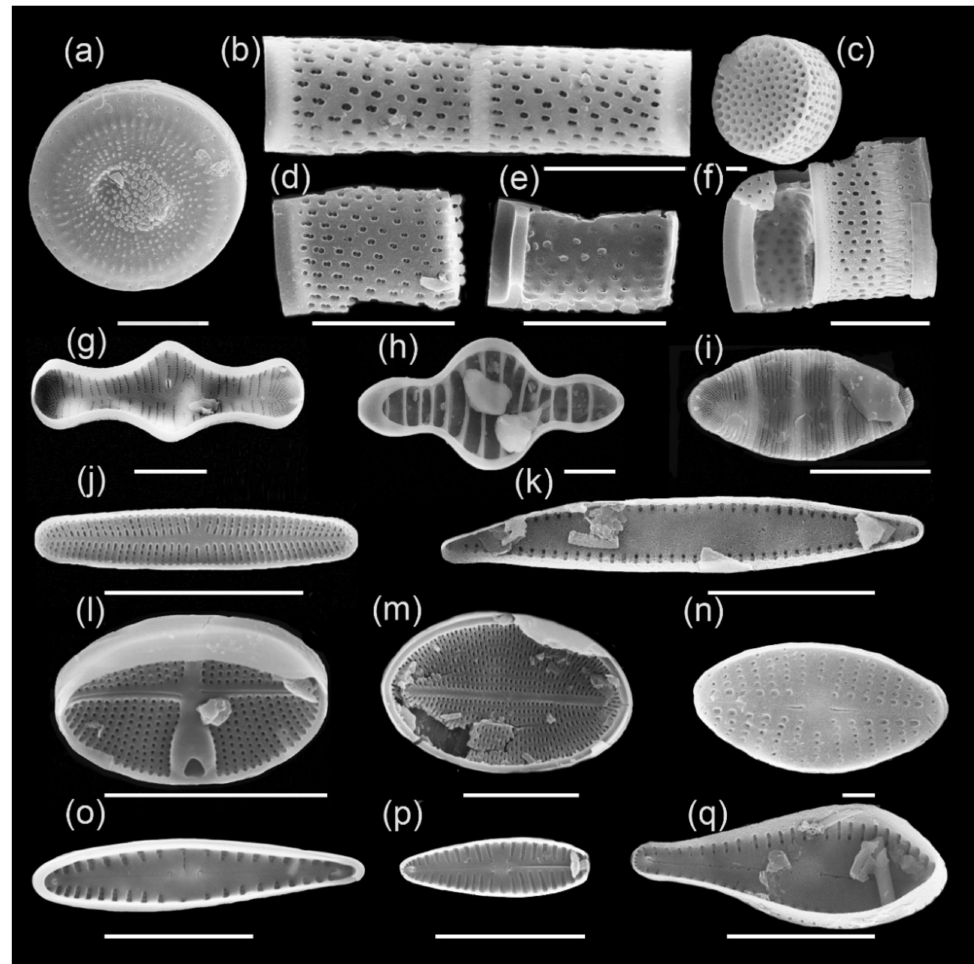
Figure 6. Main complex of diatoms of Ecozone II: ( a ) Cyclotella tuncaica, ( b , d , e ) Aulacoseira aff. baicalensis, ( c ) Aulacoseira distans, ( f ) Aulacoseira sp., ( g ) Tabellaria flocculosa, ( h ) Tetracyclus glans, ( i ) Odontidium mesodon, ( j ) Achnanthidium minutissimum, ( k ) Staurosira subsalina, ( l ) Gliwiczia calcar, ( m ) Cocconeis placentula, ( n ) Eolimna minima, ( o ) Gom- phonema intricatum, ( p ) Gomphonella olivacea, ( q ) Gomphosphenia grovei var. lingulata. Scale bars: 10 µ m ( a , b , d – m , o – q ) and 1 µ m ( c , n